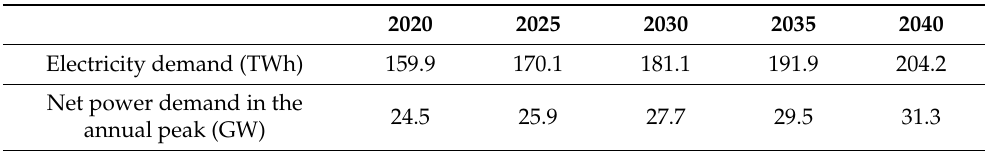
Table 2. The production of renewable energy sources in the annual peak in Poland—situation as of 30 August 2021.